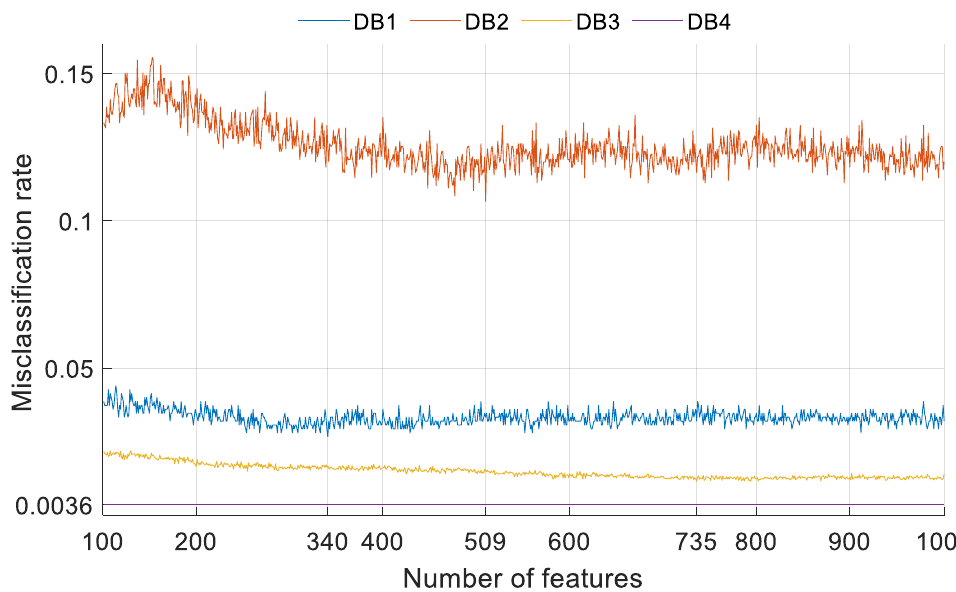
Figure 7. Plot of misclassification rate versus the number of features obtained for various databases.